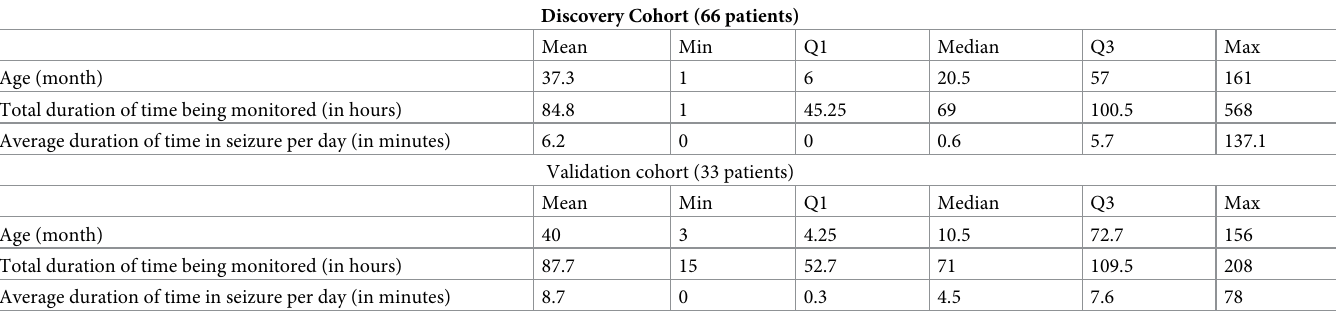
Table 1. Overview of patients in the discovery and validations